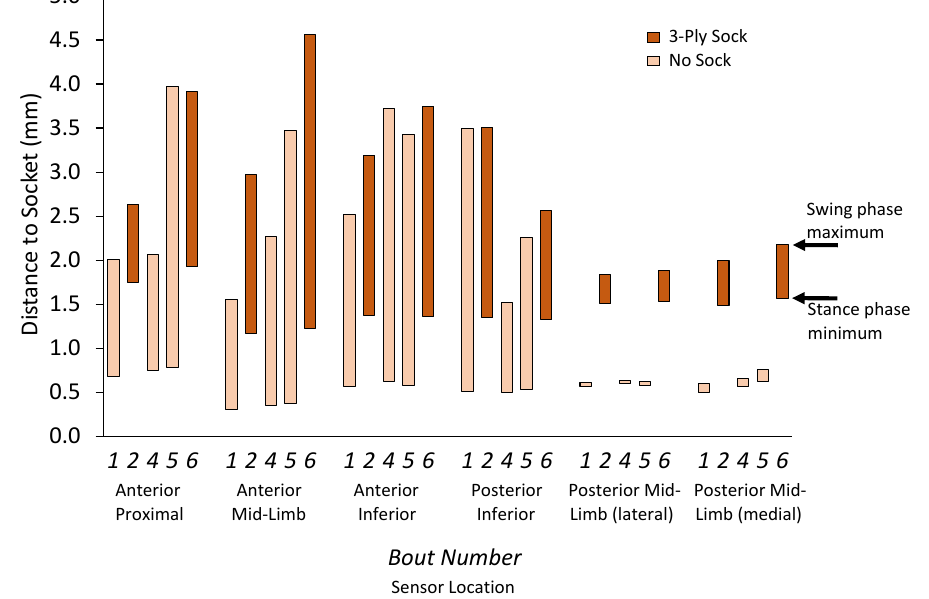
Figure 8. Range of limb–socket distance within a step: swing phase maximum and stance phase minimum. Results from steps wearing a three-ply sock and no sock during a trial are shown.